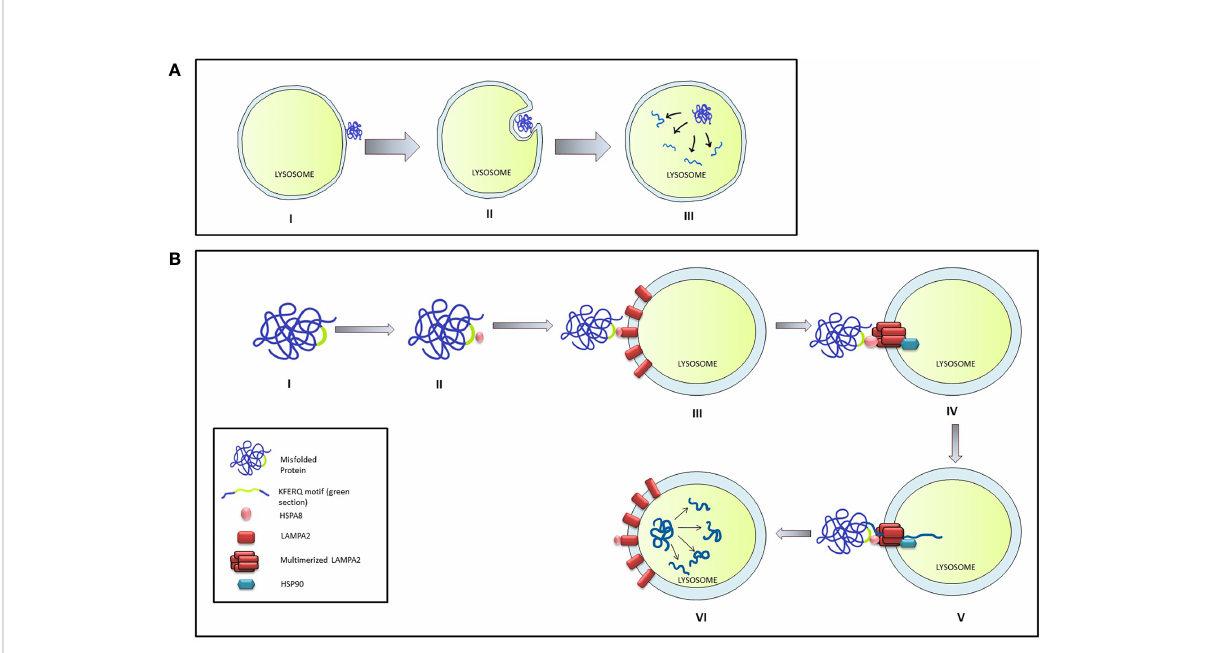
FIGURE 2 Micro-autophagy and Chaperone mediated autophagy in mammalian cells. (A) The stages of Micro-autophagy. I: Unfolded or damaged proteins present near the lysosomal surface triggers micro-autophagy. II: Invagination of lysosomal membrane into a cup shaped depression engulfs and degrades the damaged protein. III: Release of the cargo in the lysosome leads to its degradation. (B) Chaperone mediated autophagy (CMA): I & II: HSPA8 binds to the mis-folded protein by interacting through the KFERQ motif. III & IV: HSPA8 delivers the cargo on the lysosomal membrane by interacting with LAMPA2. Multimerization of LAMPA2, also mediated through HSPA2, creates a channel which is stabilized by interaction with HSP90. V & VI: HSPA8 mediates the unfolding of the protein and its translocation to the lysosomal matrix, where the cargo is